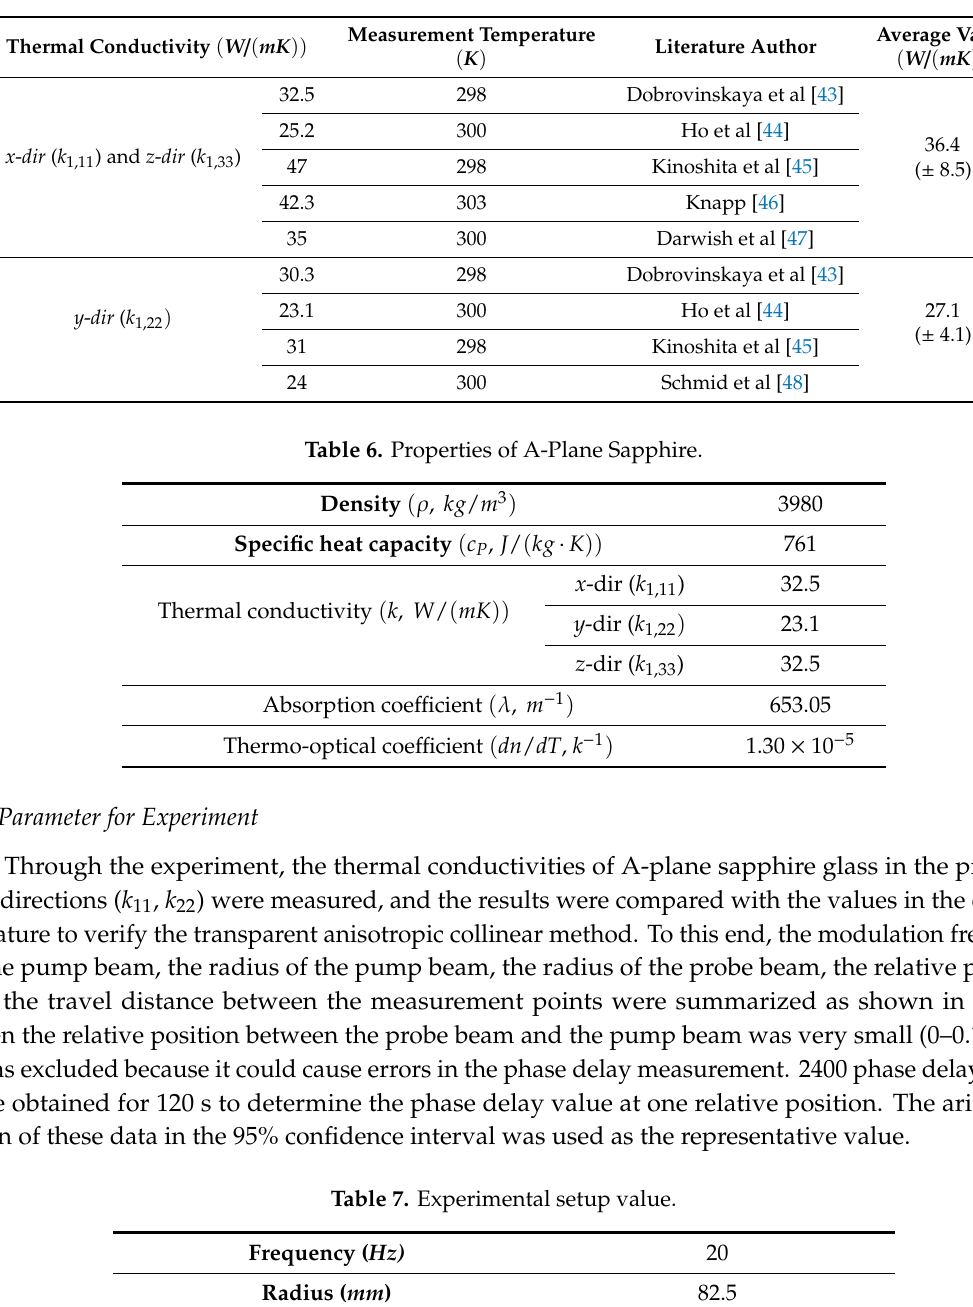
Table 5. Literature values of thermal conductivity for sapphire glass.